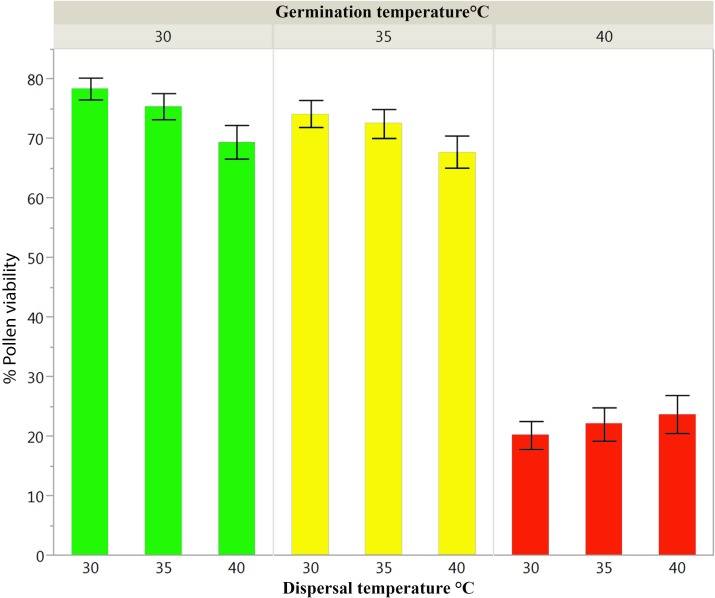
Mean percentage viability of pollen incubated at 30, 35, and 40°C at dispersal and reciprocally germinated at 30 (green), 35 (yellow), and 40°C (red) along the elevational gradient using all sites combined. Error bars were constructed using one standard error from the mean.